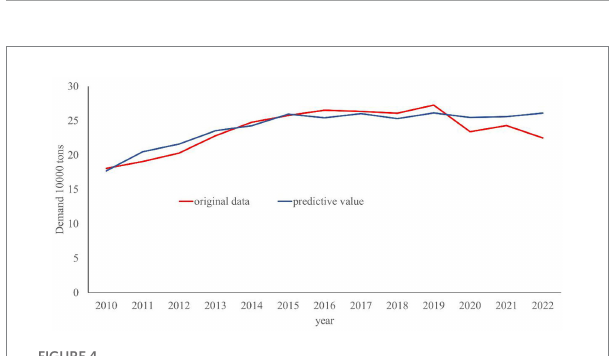
FIGURE 4 Combination prediction fitting diagram.